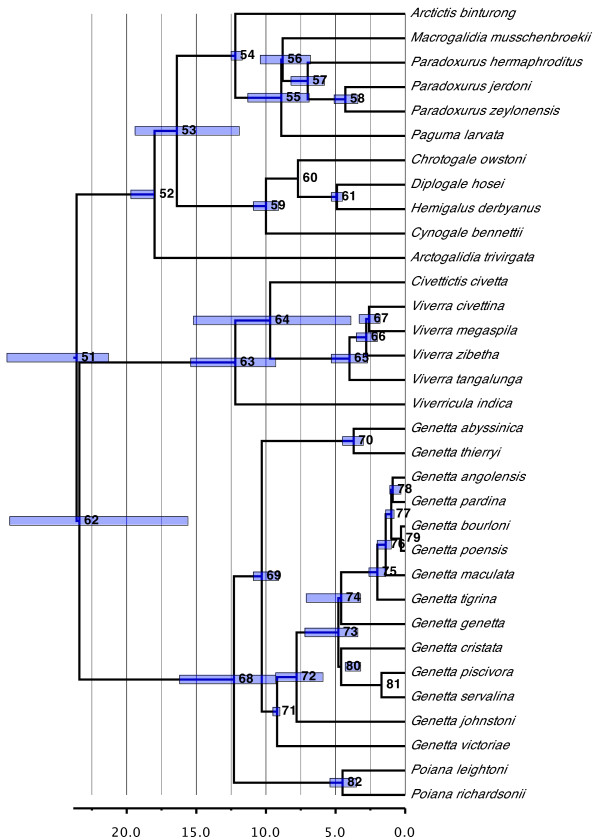
Phylogenetic relationships and divergence times estimates within Viverridae. Nodes are individually numbered, with node bars indicating 95% confidence intervals on the divergence time estimates (in Ma before present).